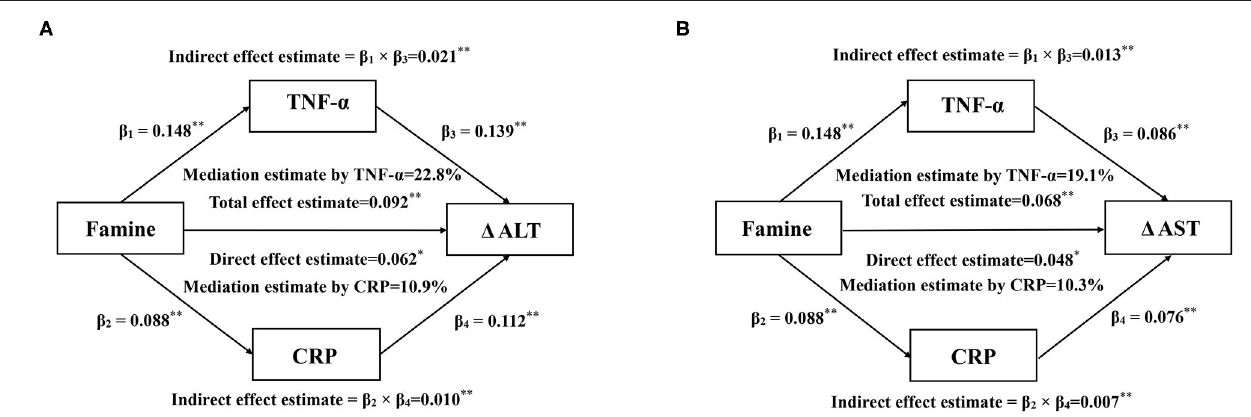
FIGURE 1 | Mediation effects of serum CRP and TNF- α on the association between prenatal famine and 1 ALT (A) and 1 AST (B) . Data are standardized regression coefficients with adjustment for age, sex, education, working strength, physical activity, smoking, drinking, energy intake, BMI, SBP, and FPG. * P < 0.05, ** P < 0.01 for coefficients being different from